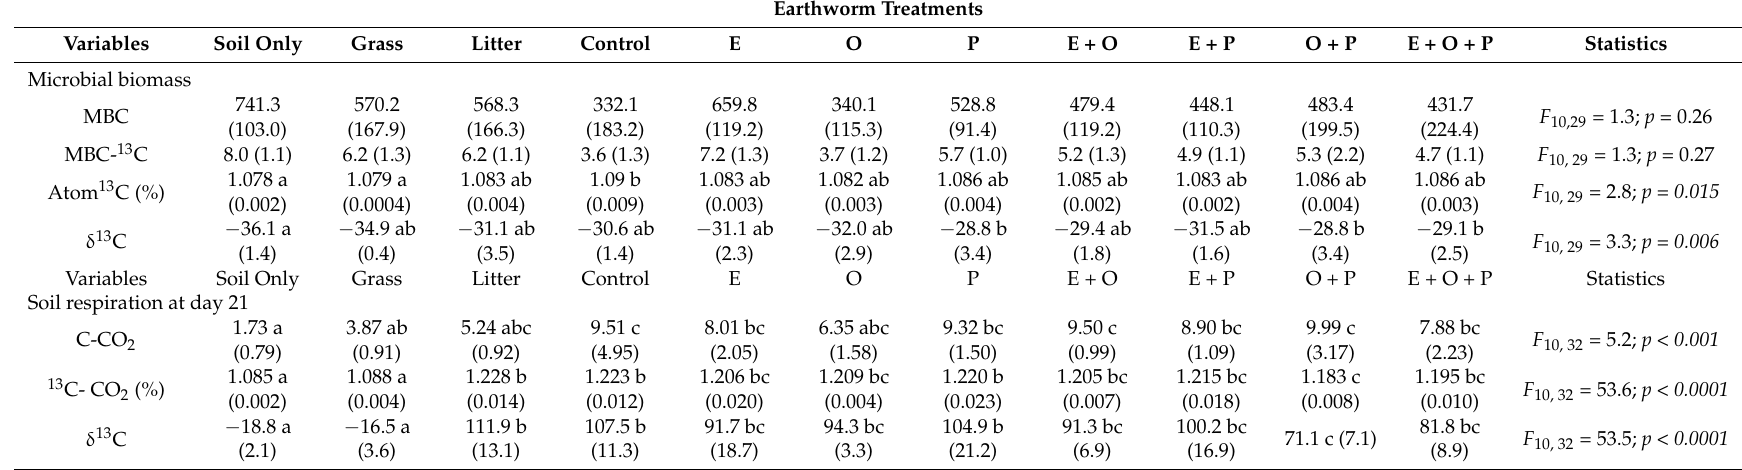
Table 5. Microbial biomass total carbon (MBC, µ g C /g soil), carbon- 13 C (MBC- 13 C; µ g 13 C /g soil), atom percentage of 13 C (%), and soil delta 13 C ( δ 13 C; ‰), soil (Grass), soil with 13 C-labeled leaf litter (Litter), and Control (soil with both grass and leaf litter but no worms)) and earthworm treatments at the end of the 22-day mesocosm experiment with Puerto Rican